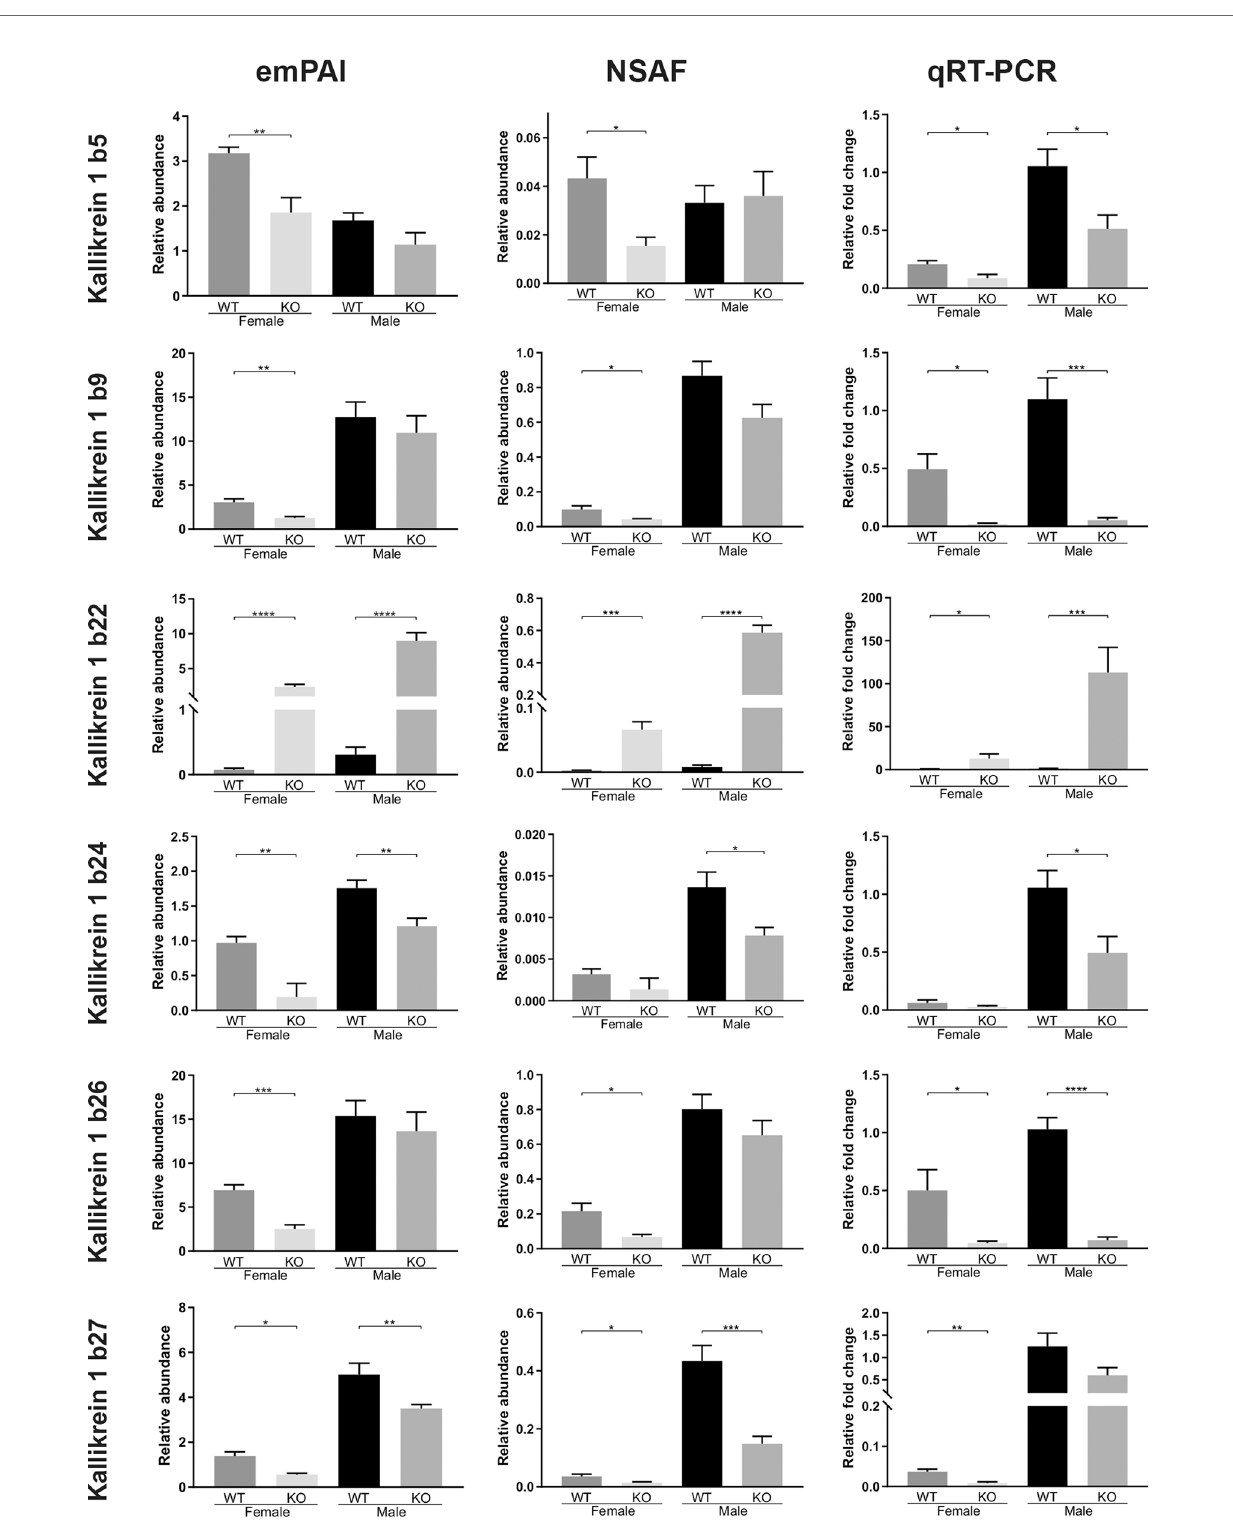
FIGURE 4 | Quantitative comparisons of various Kallikrein 1-related proteases in the murine submandibular salivary gland tissue, at the protein level (NSAF and emPAI mass spec quanti fi cations of relative abundances) and at the transcription level (qRT-PCR comparative fold change amounts). All animals in the proteomic analysis (n = 6) were also subsequently analyzed with qRT-PCR. Data are presented as mean values ± SEM. Statistically signi fi cant differences according to t-test between FWT vs FKO or MWT vs MKO groups are indicated as *p < 0.05, **p < 0.01, ***p < 0.001 and ****p < 0.0001.